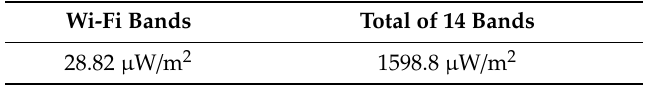
Table 1. Intensity from Wi-Fi band and the total exposure from the 14 bands.